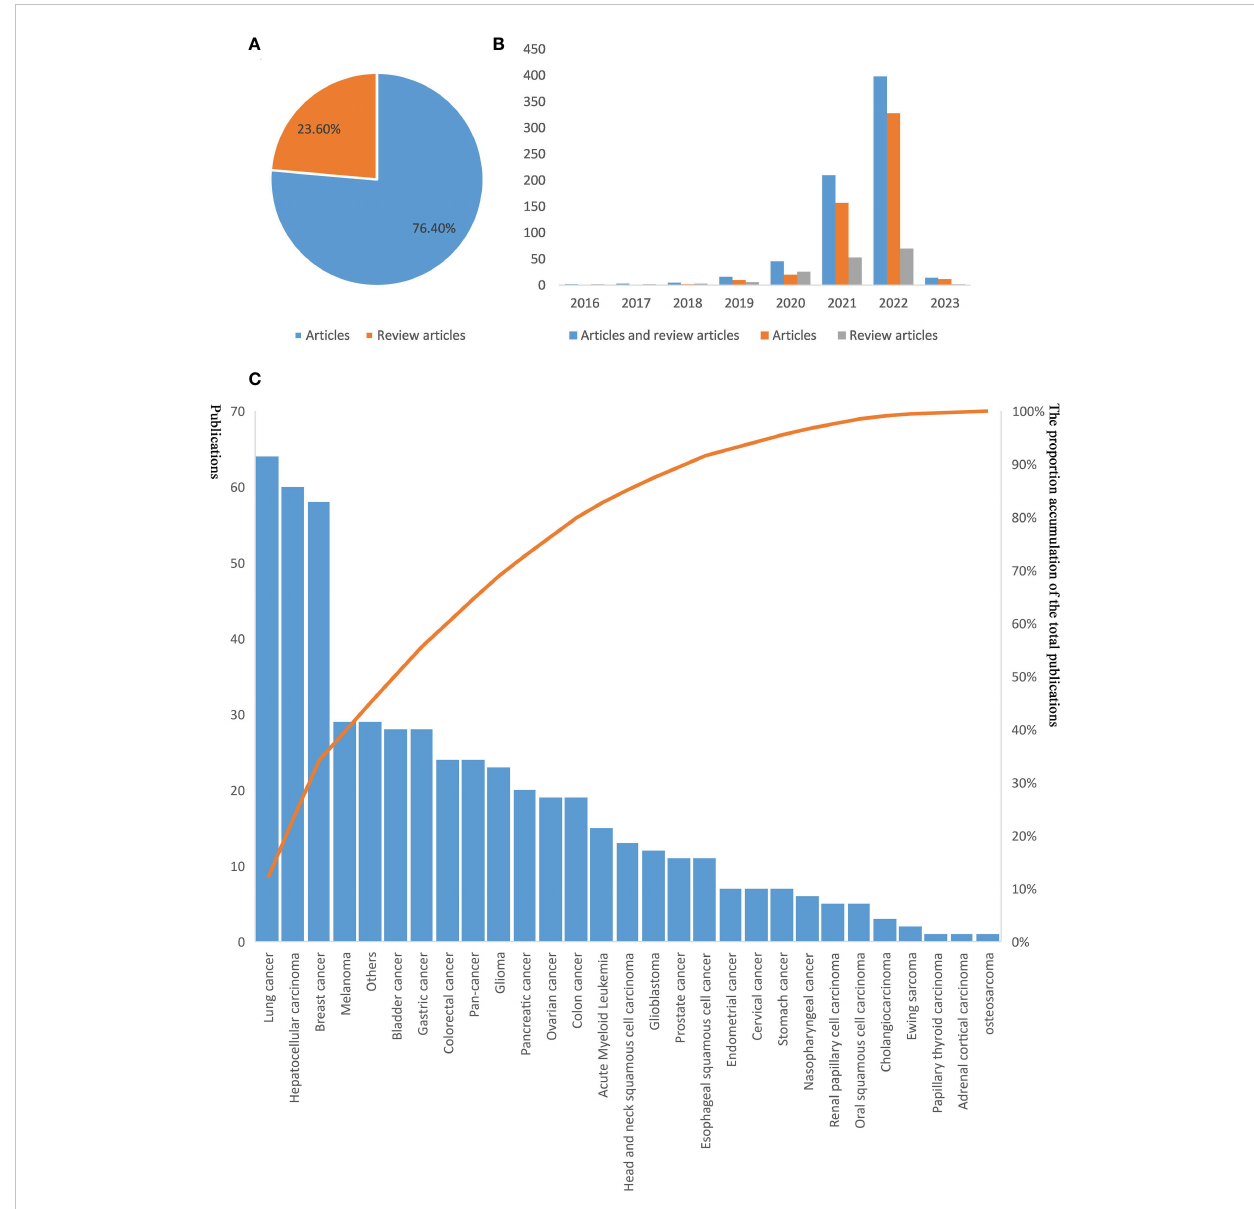
FIGURE 3 The distribution among years, article type, and cancer type. (A) the proportion of articles and reviews. (B) abscissa axis on the publication year. The vertical coordinate represents the number of published documents, the blue column represents the sum of the article and reviews article documents, the orange column represents article documents, the gray column represents review article documents. (C) distribution of involved cancer